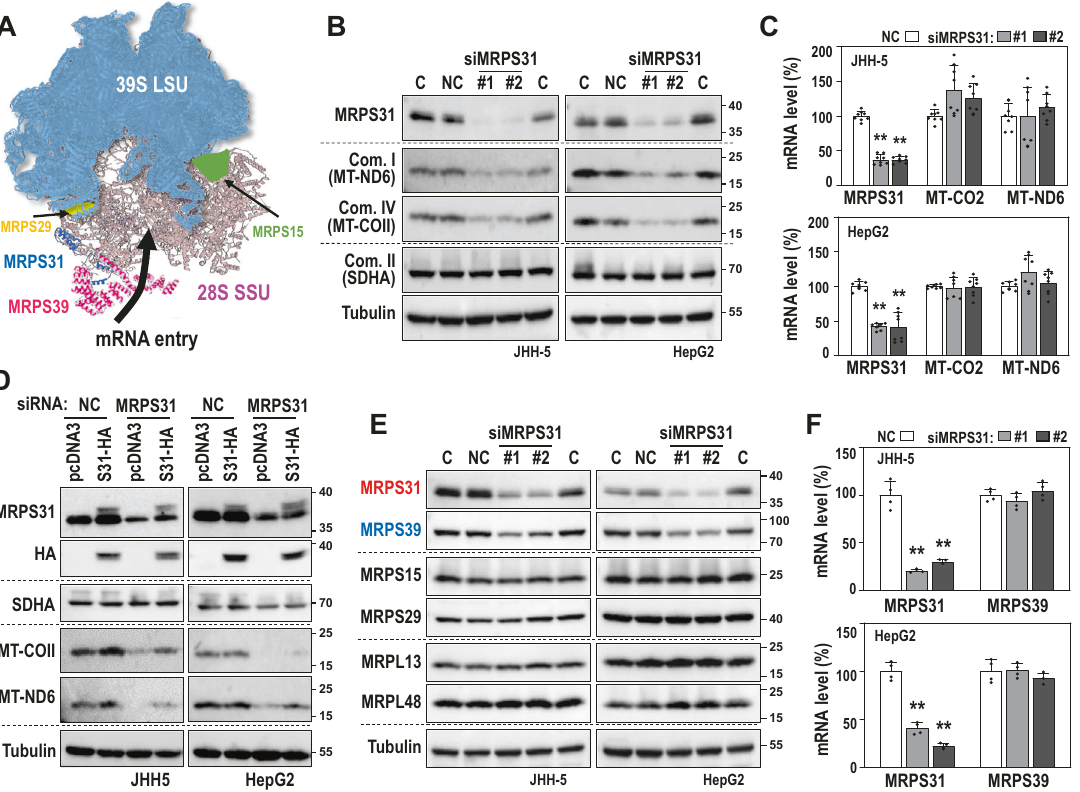
Fig. 4 MRPS31 protein level is linked to MRPS39 protein level at translation level. A The schematic structure of human mitoribosome based on protein data bank (PDB). The 39 S large subunits (LSU) is colored in light blue and 28 S small subunits (SSU) in pink. Some small subunit proteins (MRPS29, MRPS31, MRPS39 and MRPS15) were marked with different colors. The mRNA entrance channel is located nearby MRPS39. B – F JHH5 and HepG2 cells were transfected with MRPS31 siRNA in the absence or presence of pcDNA3-MRPS31-HA plasmid